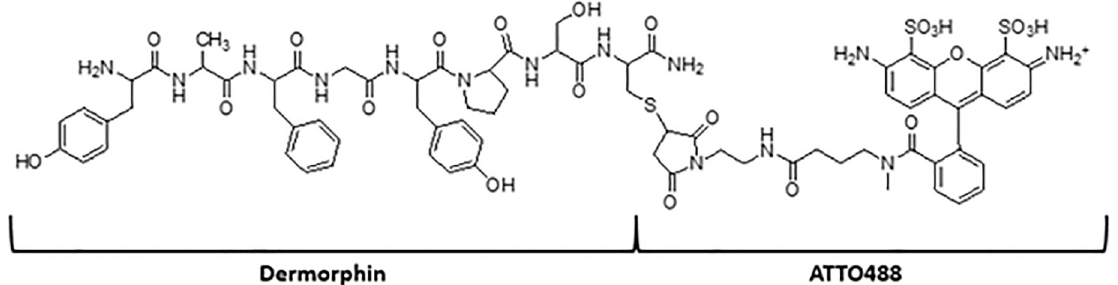
Fig 1. Chemical structure of